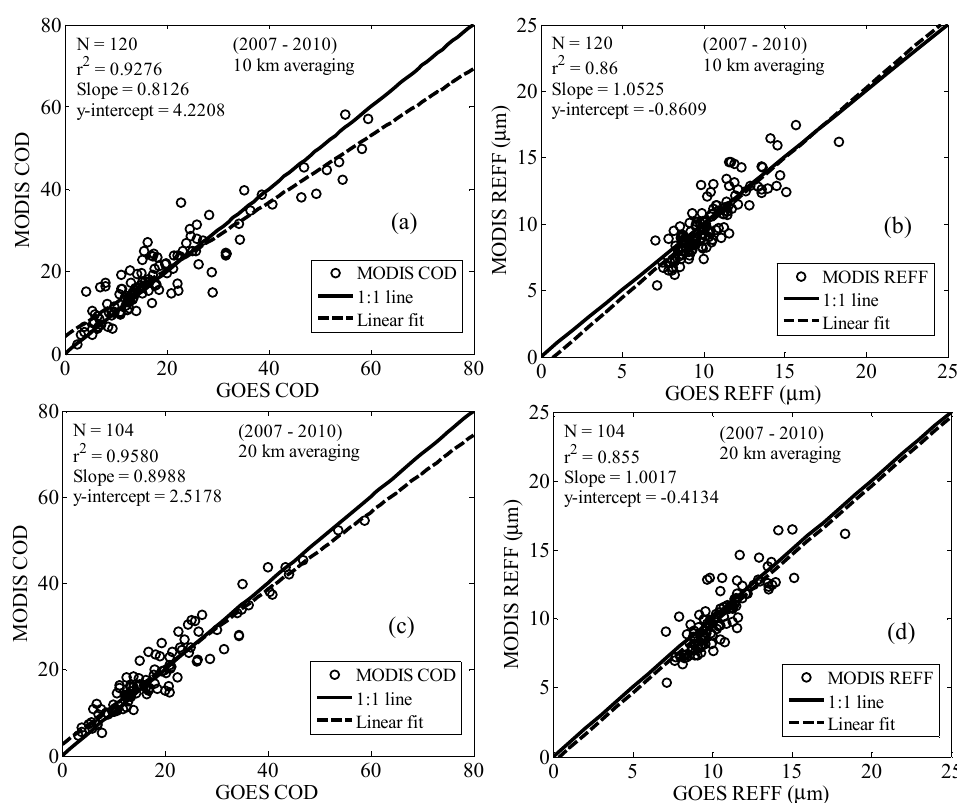
Figure 2. Comparison plots of Moderate Resolution Imaging Spectroradiometer (MODIS) and Geostationary Operational Environmental Satellites (GOES) derived Cloud Optical Depth (COD) and Cloud Droplet Effective Radius (REFF) with 10 km ( a , b ) and 20 km ( c , d ) averaging centering ARM SGP site Lamont (Oklahoma) for the data covering